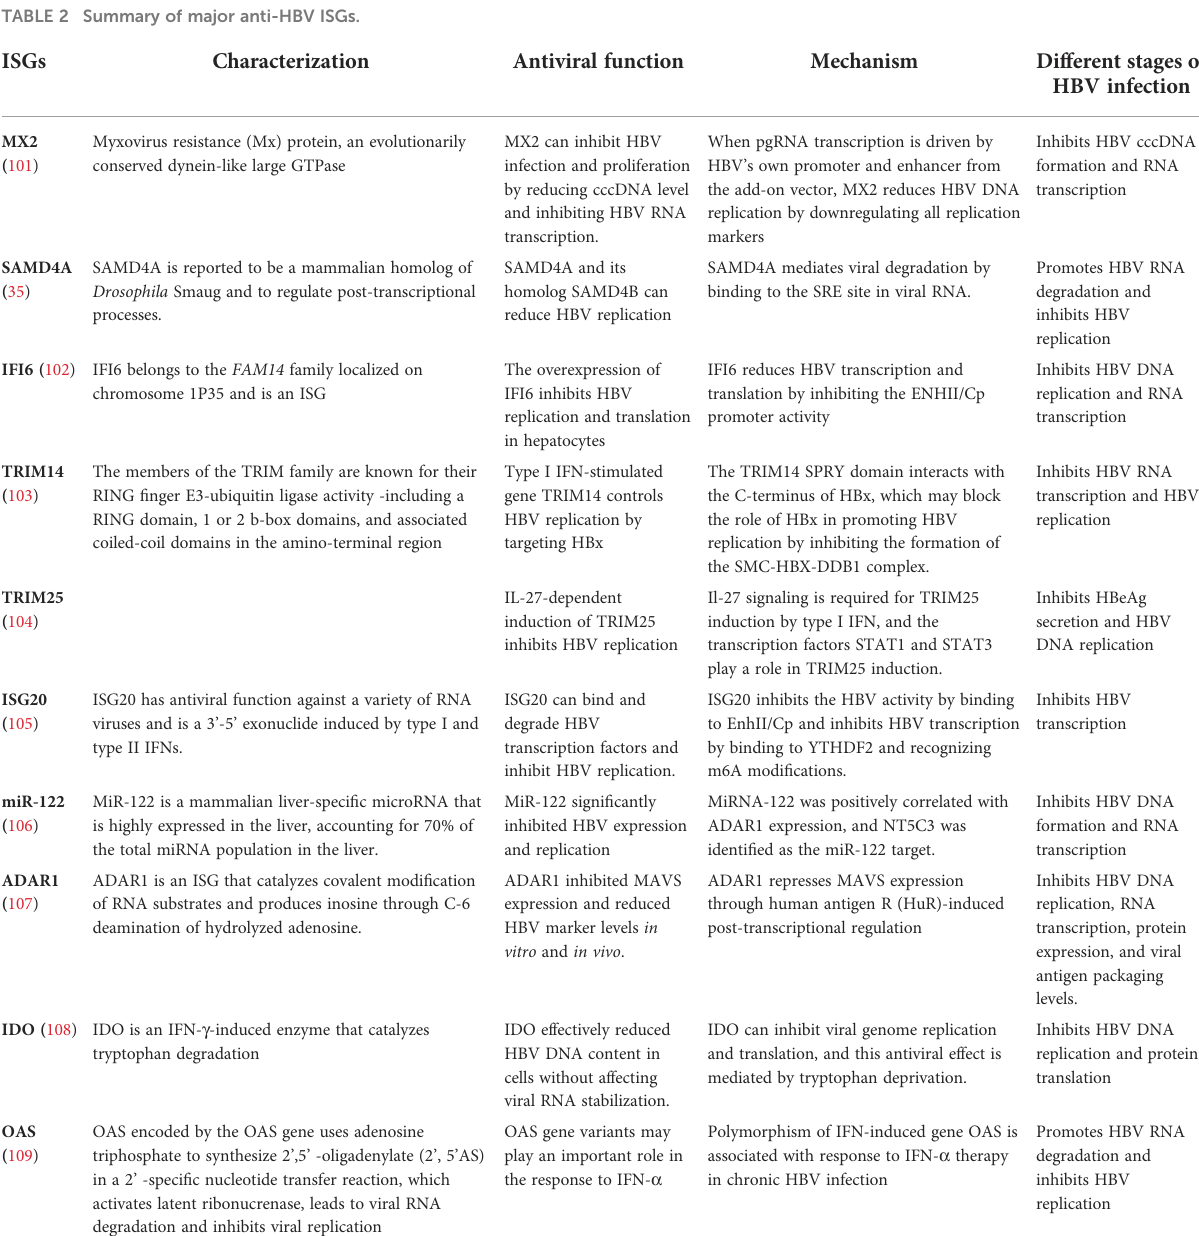
TABLE 2 Summary of major anti-HBV